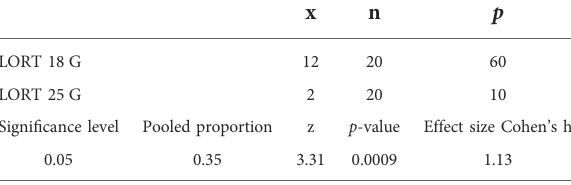
TABLE 2 The 95% con fi dence interval test for proportions of epidural space detection by LORT within 18 G and 25 G groups. x n p Margin of error